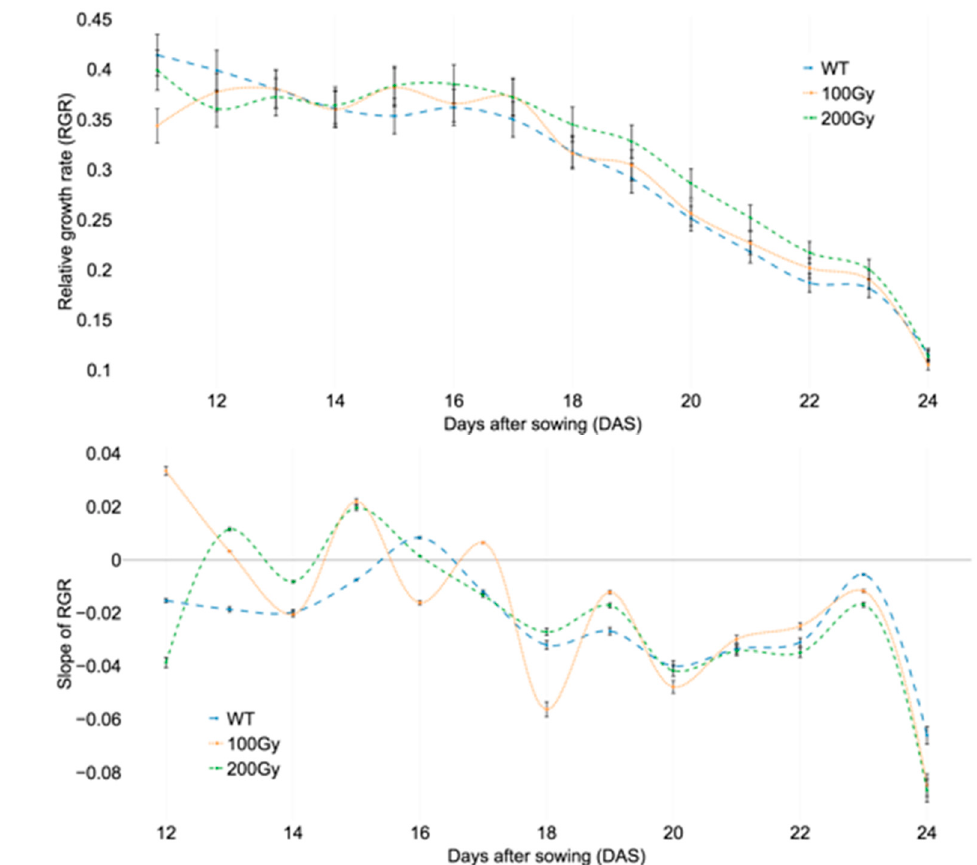
Figure 3. Comparing relative growth rate (RGR) of Arabidopsis seeds irradiated at 100, 200, 300, and 400 Gy of gamma radiation ( 60 Co). Results are means ± SD ( n = 96). ( A ) All treatments are shown as the average of 96 plants per treatment except 128 plants for wild type. ( B ) Only 100 and 200 Gy treatments are shown. ( C ) Slope of RGR.